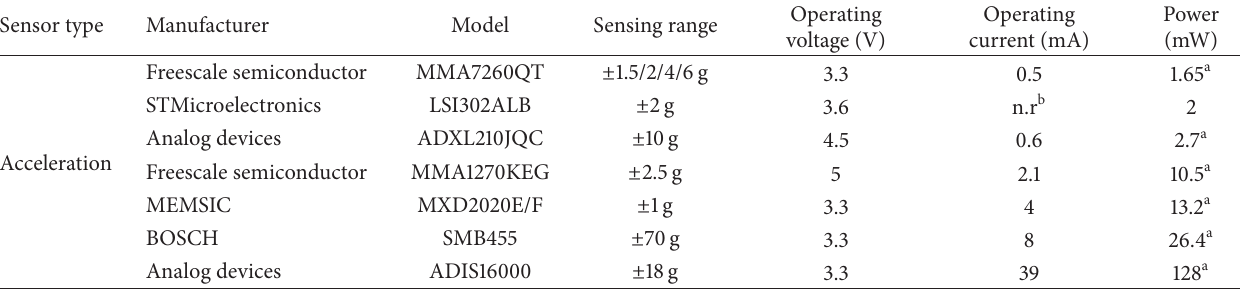
Table 1: Summary of commercially available wireless sensors nodes.